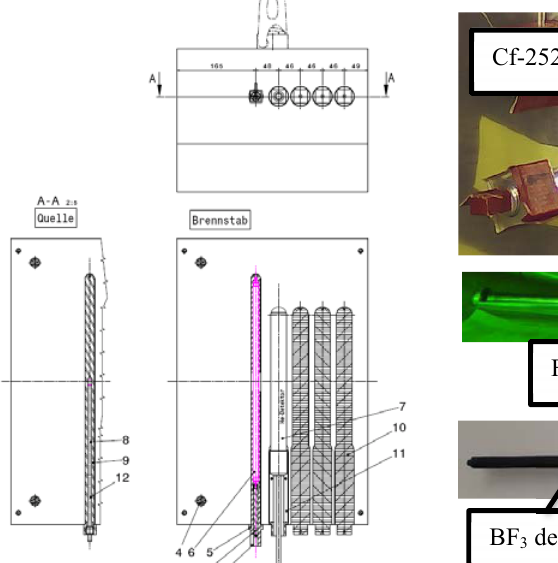
and BF detector 3